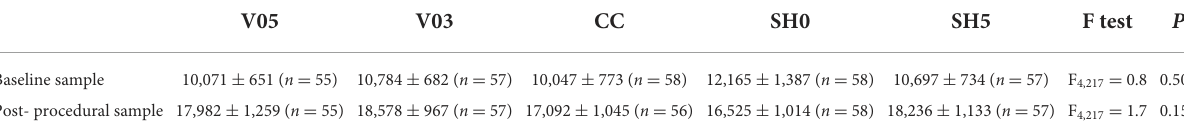
TABLE 8 Averages ( ± SE) saliva cortisol concentrations (pg/mL) sampled at baseline and approx. 17min post-castration/last sham